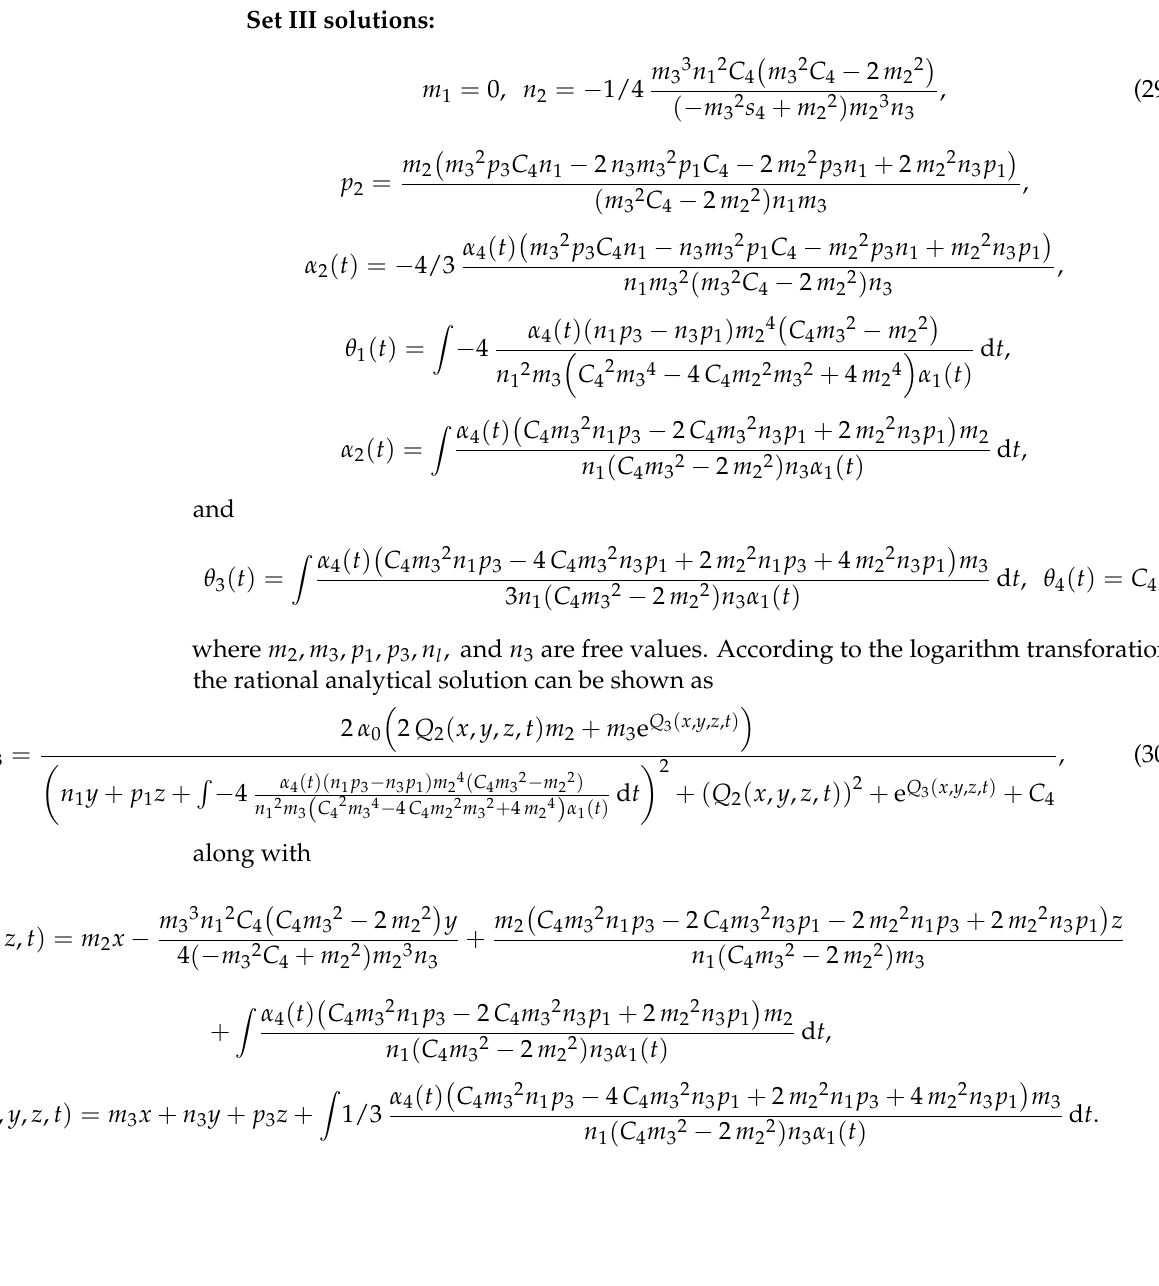
Figure 2. Plot of lump one-soliton solution (26) ( Γ 2 ) such as density plot for three times t = 0,1,1.8, respectively, sub figures ( f1 , f4 , f7 ) for t = 0, sub figures ( f2 , f5 , f8 ) for t = 1, and sub figures ( f3 , f6 , f9 ) for t =